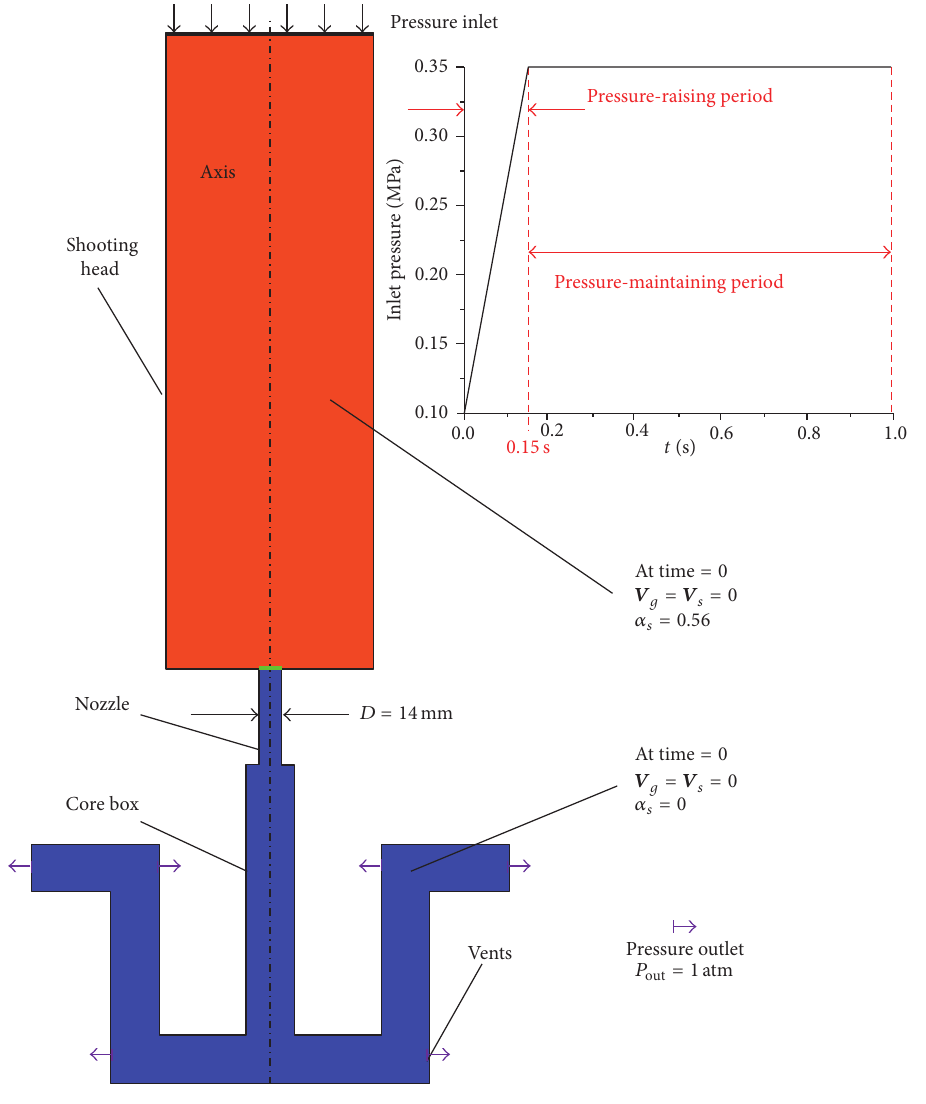
Figure 2: Simulation sets and the setting of inlet pressure.